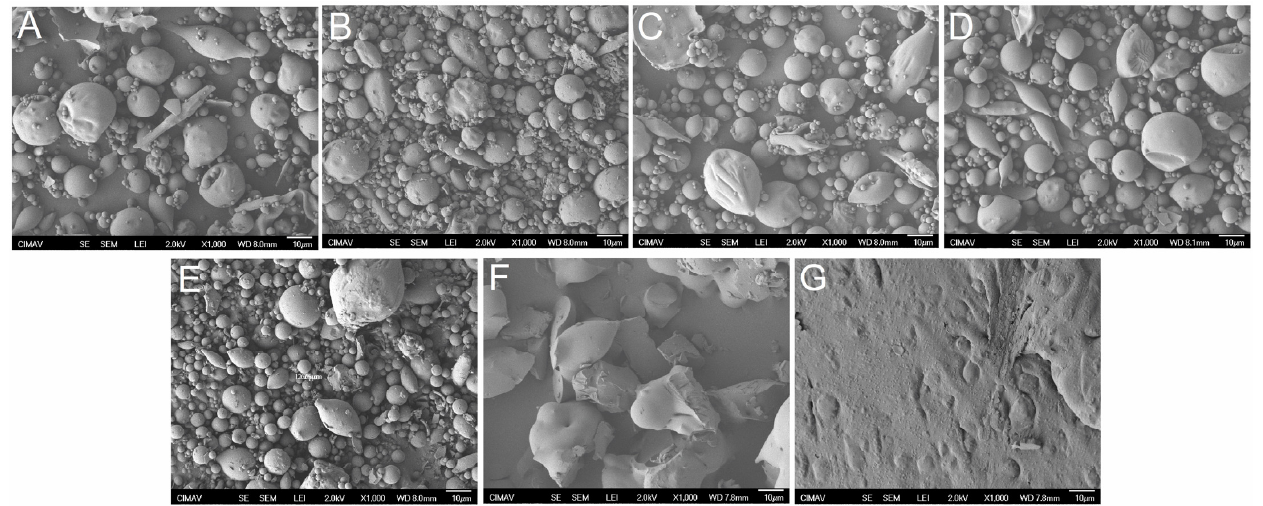
Figure 4. SEM micrographs of the functional food blend MX-IN:25-75 at the different a w values: ( A ) 0.073, ( B ) 0.229, ( C ) 0.331, ( D ) 0.43, ( E ) 0.531, ( F ) 0.75, and ( G ) 0.856.